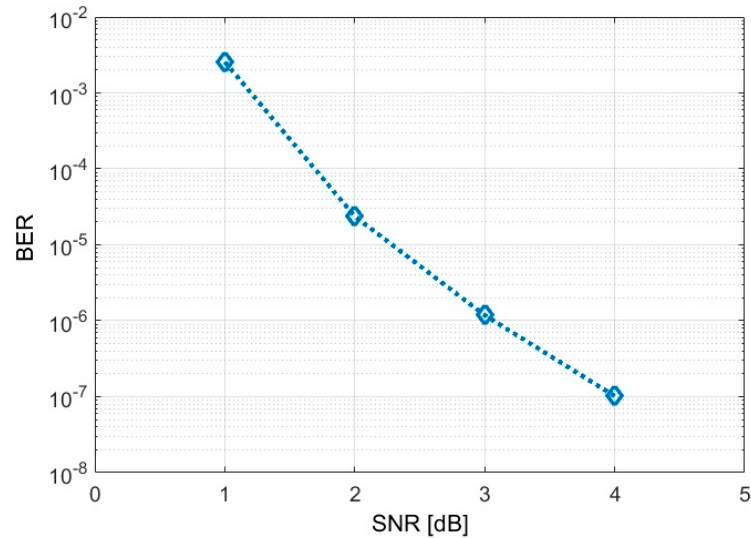
Figure 9. BER as a function of the SNR.